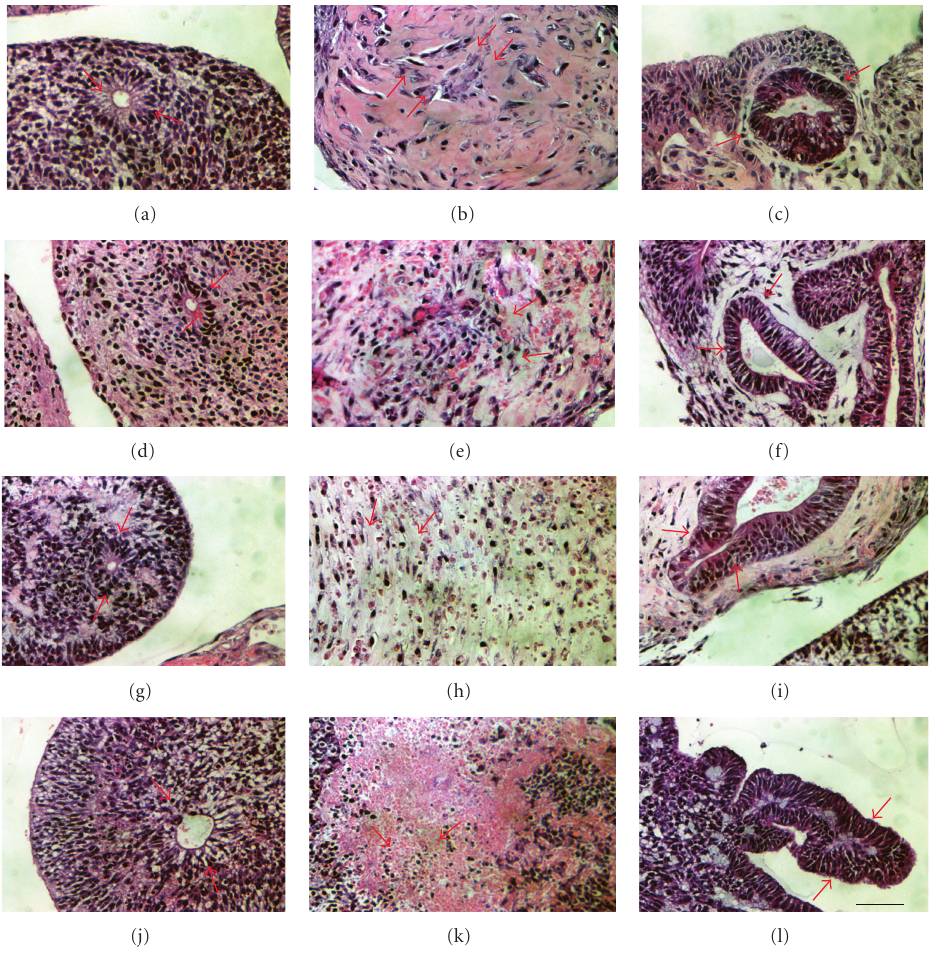
Figure 2: Histological evidence of germ layer di ff erentiation in embryoid bodies generated from human pluripotent stem cells cultured by di ff erent methods to illustrate equivalence of culture techniques [63]. Shown are images of hematoxylin and eosin-stained histologic sections of EBs from hESCs propagated directly on mouse embryonic fibroblast (MEF) feeder layer (top row, a–c) or hESCs propagated in indirect coculture with MEFs (second row, d–f), hiPSCs propagated on MEFs (third row, g–i), or hiPSCs propagated in indirect coculture with MEFs (bottom row, j–l). Equivalent trilineage potential is demonstrated by presence of ectodermal (neuroepithelial) (a, d, g, and j); mesodermal (fibrous connective) (b, e, h, and k), and endodermal (intestinal) (c, f, i, and l) di ff erentiation in these EBs. Arrows point to the